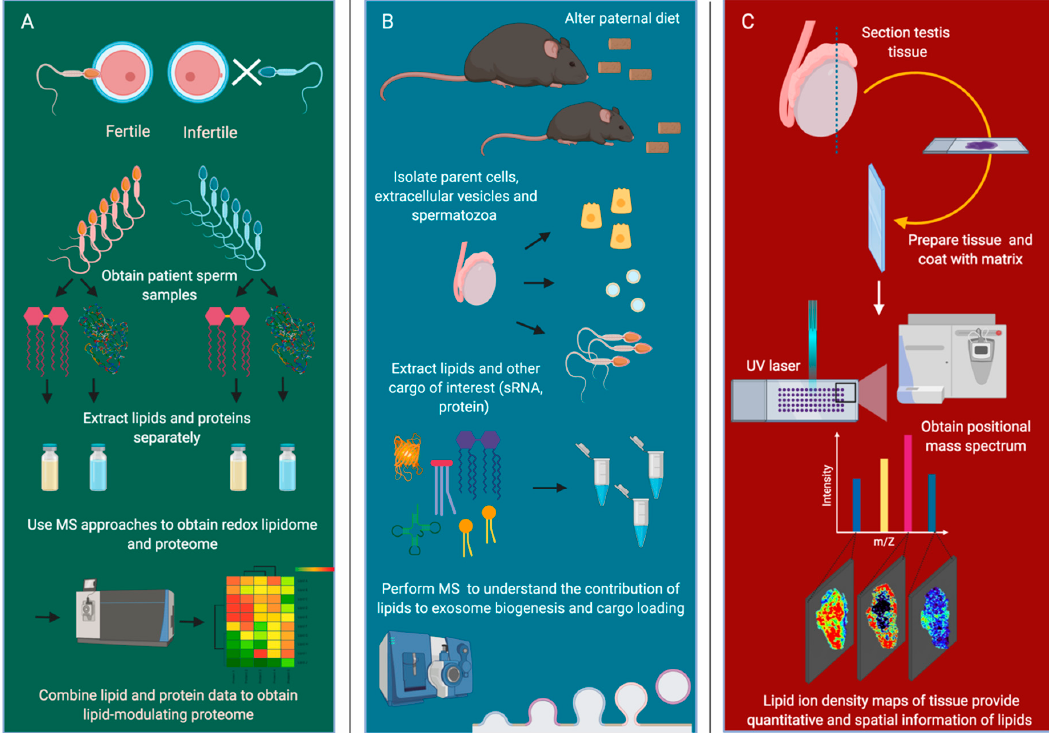
Figure 3. Applications for lipidomics in reproductive biology. ( A ) Multi-omics approaches are yet to be used to understand key differences between fertile and infertile sperm samples. Here, we propose the combination of redox lipidomics and proteomics will yield important insights into the lipid changes that form the basis of infertility and the enzymes that may be responsible for these changes.